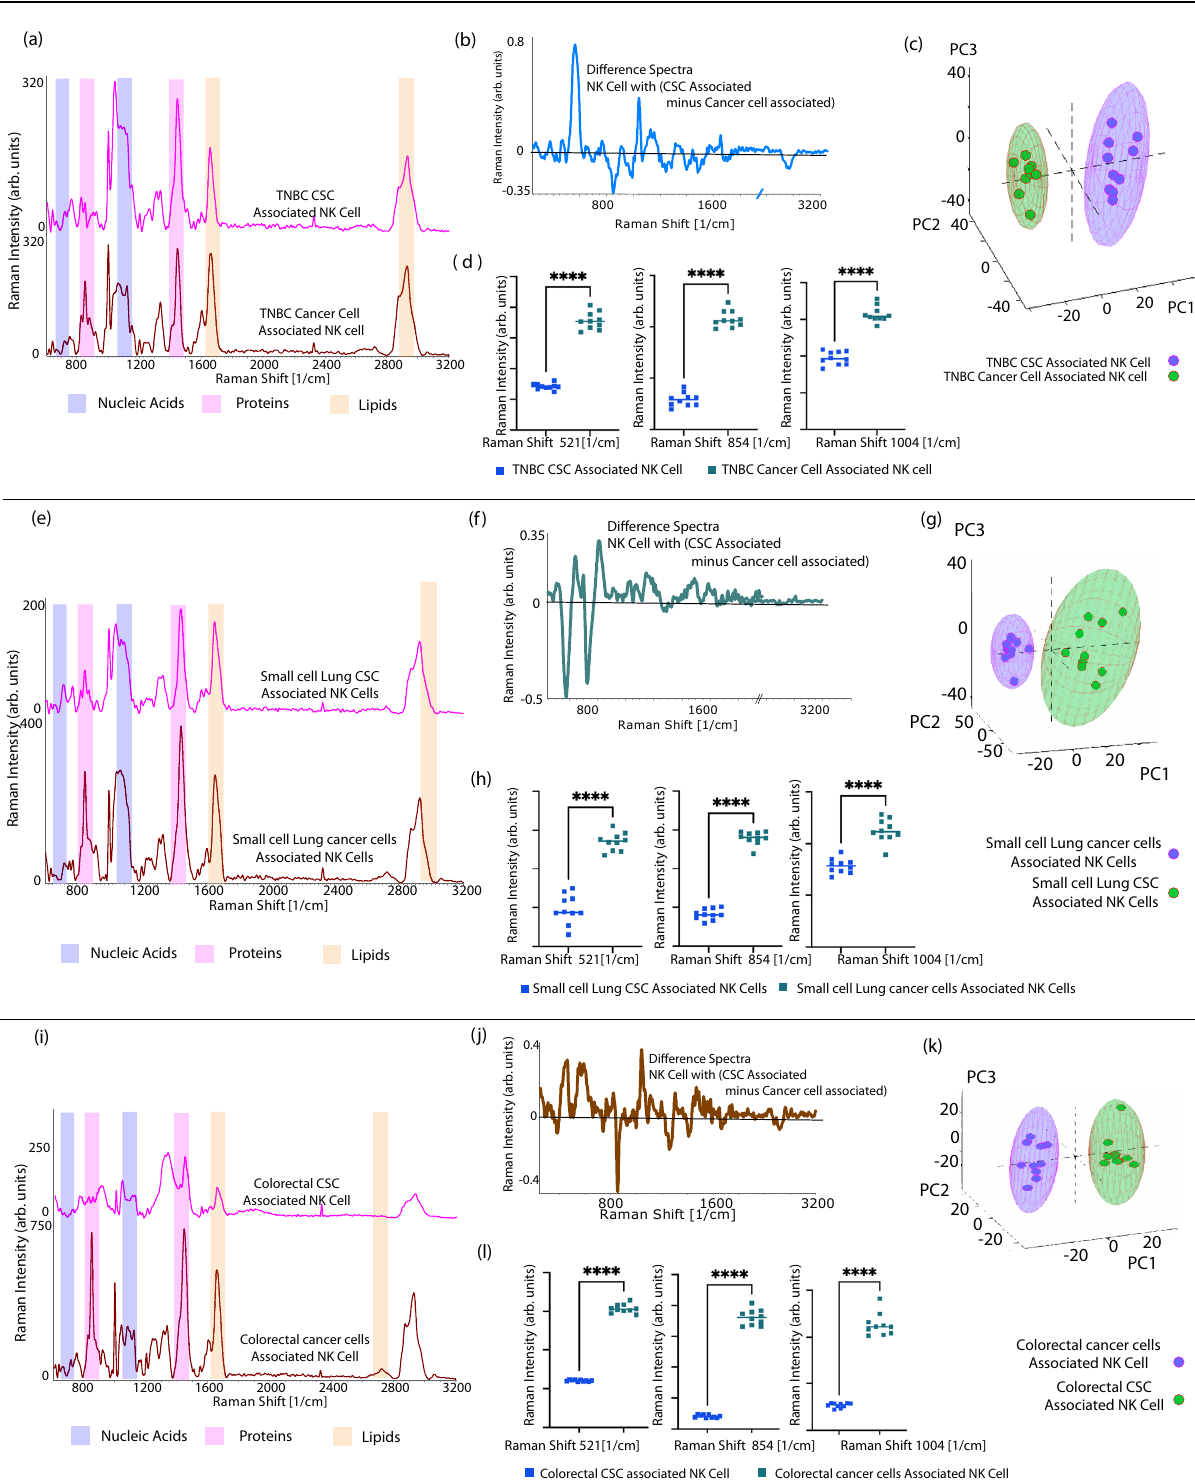
Fig. 7 | Variation in the signals of cancer cell and CSC-associated NK Cell. a Spectral variation for triple negative breast adenocarcinoma. Pink spectra for CSC-associated NK cell, maroon spectra of cancer-cell-associated NK cell. b Difference spectra for breast. c Principal component analysis showing clear separationof cancer-associated,and CSC-associatedNKcells. d Two tailed t